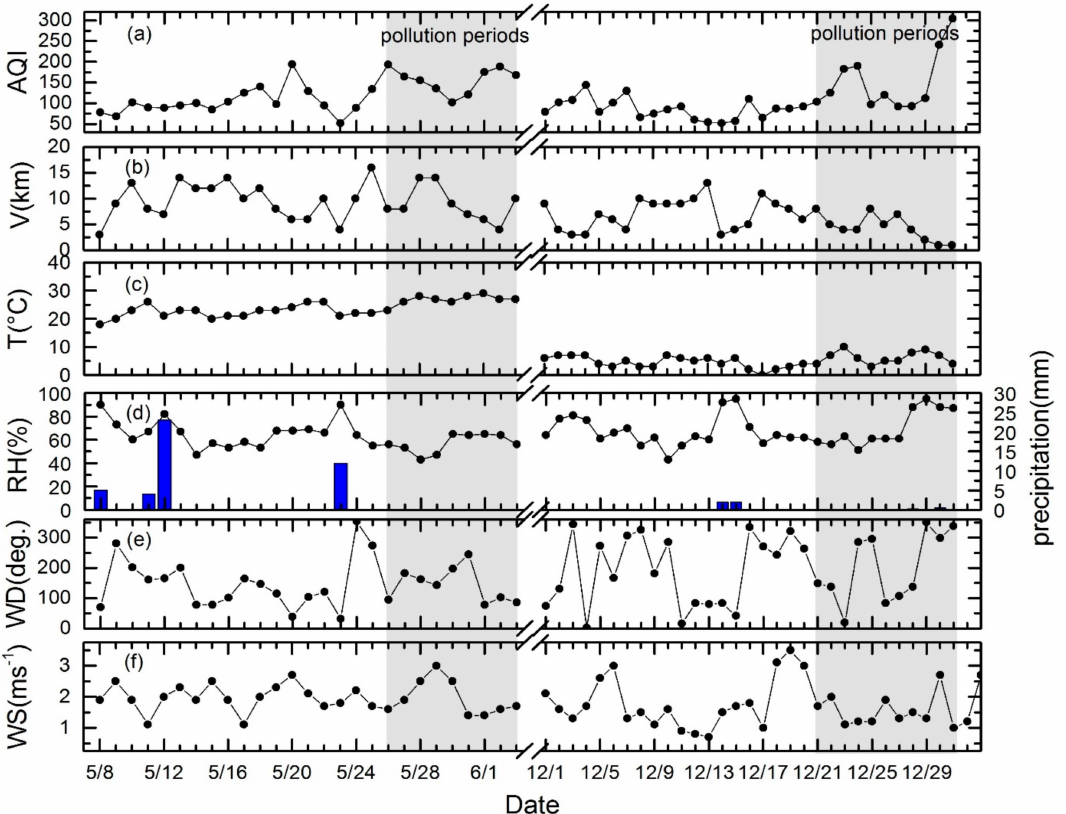
Figure 3. Daily variation of ( a ) AQI (air quality index), ( b ) visibility (V), ( c ) temperature (T), ( d ) RH (relative humidity), ( e ) WD (wind direction), ( f ) WS (wind speed) during the summer and winter pollution episodes, and the weeks preceding